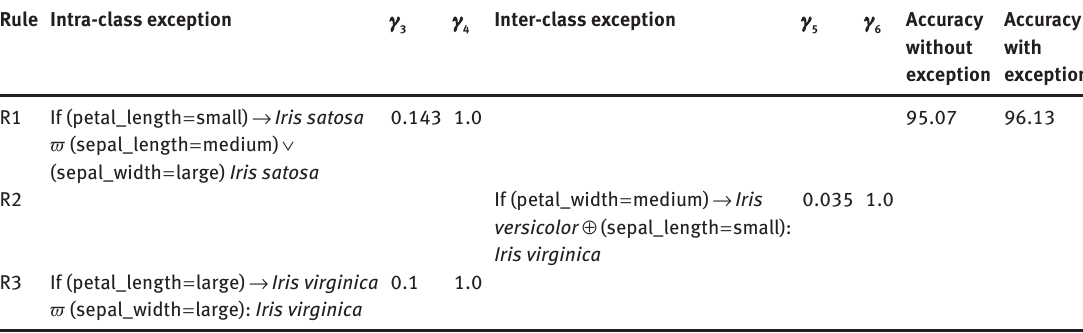
Table 6: FCRs with Intra- and Inter-Class Exceptions for the Iris Data Set.